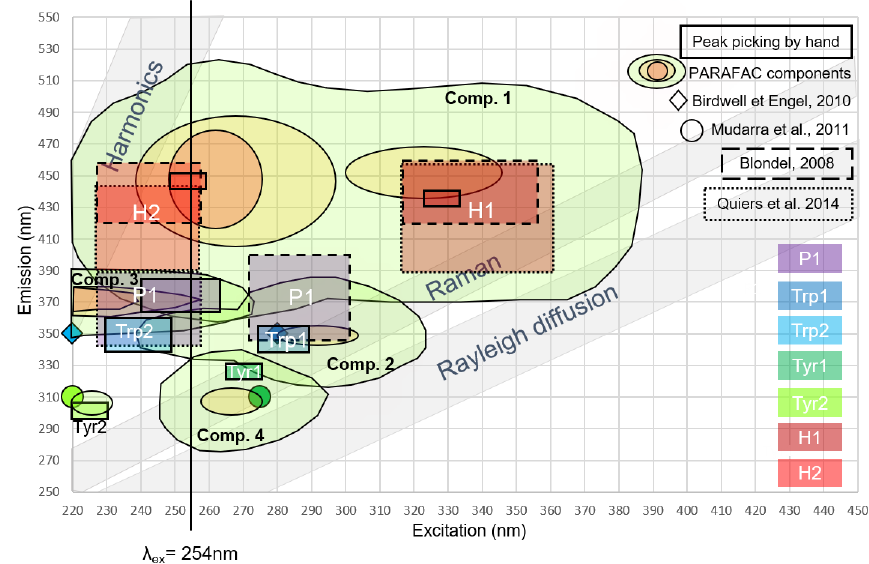
Figure 3. Comparison of organic matter component location in EEMs in literature and our